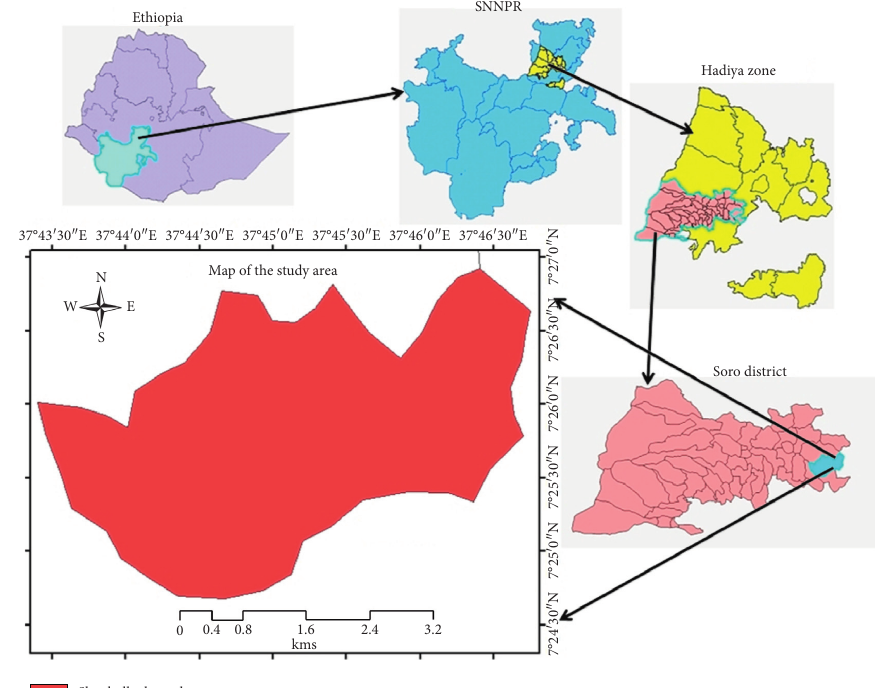
Figure 1: Map of the study area within the southern region of Ethiopia.